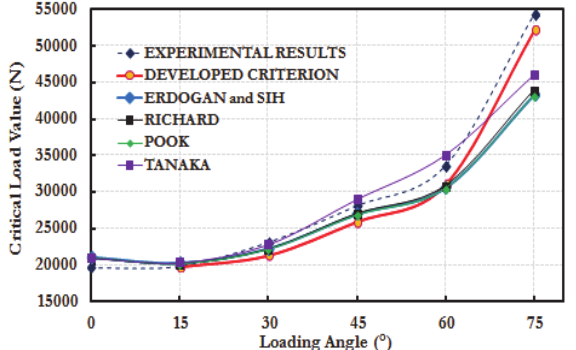
Figure 2: Comparisons of experimental and predicted T-specimen fracture load values.